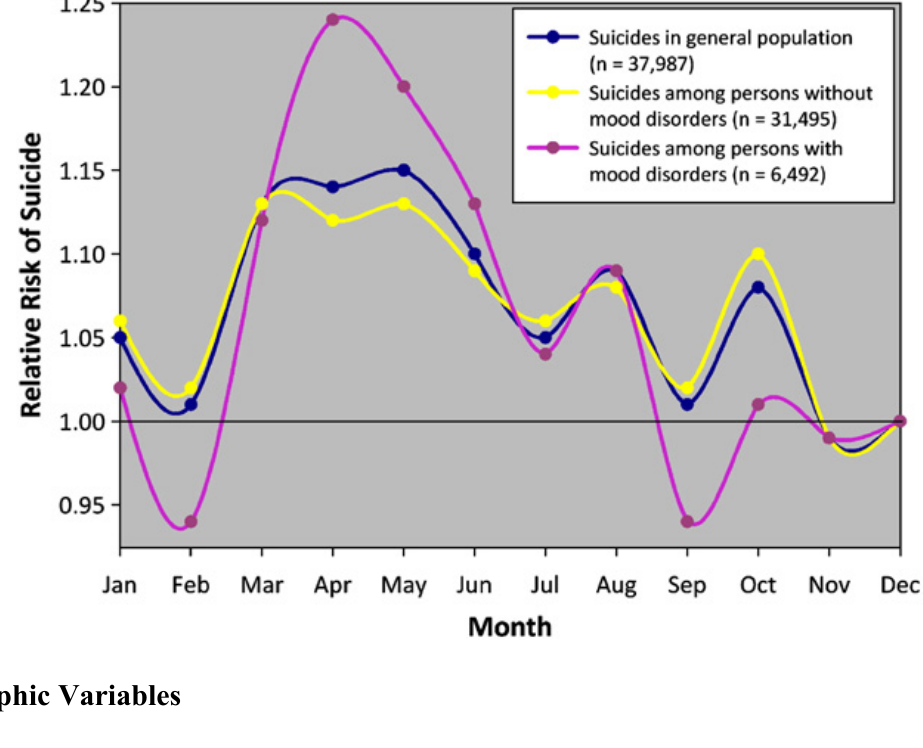
Figure 1. Monthly rates of suicide based upon all cases of suicide from 1970 to 2001in the Danish Cause of Death Registry. History of mood disorder was obtained from the Danish Psychiatric Central Register. The authors estimated the monthly rate ratio of suicide relative to December. Conditional logistic regression analyses with adjustment for place of residence, marital status, income, and method of suicide were used to compare seasonality of suicide in victims with versus without hospitalization for mood disorders. A statistically significant spring peak in suicide was observed in both groups. A history of mood disorders increased the risk of suicide in spring (for males: RR = 1.18, 95% CI 1.07–1.31; for females: RR = 1.20, 95% CI 1.10–1.32). Reproduced from [19] with